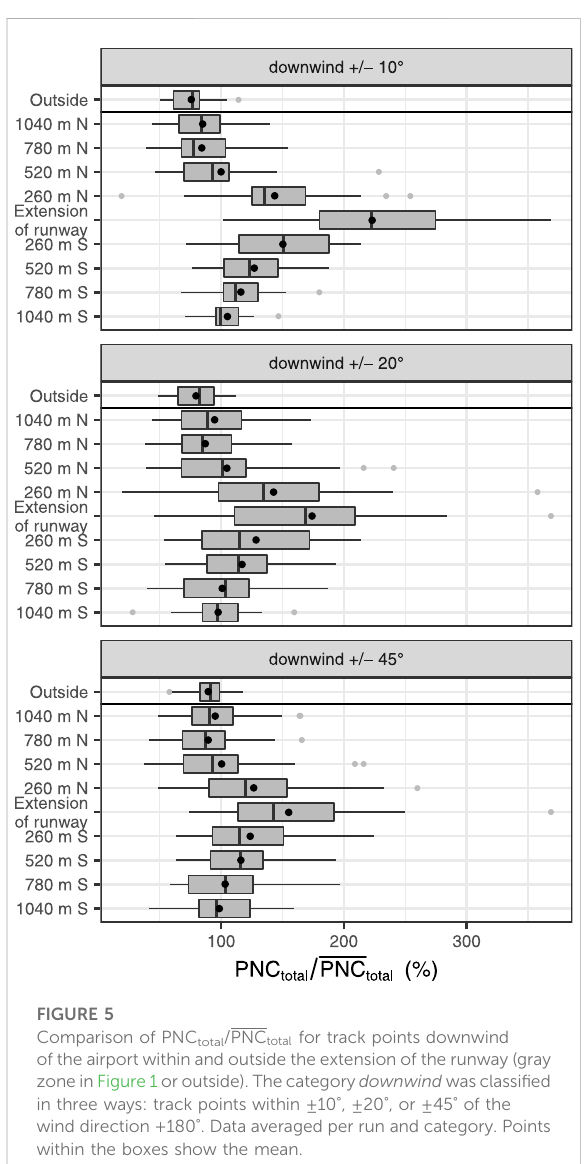
FIGURE 5 Comparison of PNC total /PNC total for track points downwind of the airport within and outside the extension of the runway (gray zoneinFigure1oroutside).Thecategory downwind wasclassi fi ed in three ways: track points within ±10 ° , ±20 ° , or ±45 ° of the wind direction +180 ° . Data averaged per run and category. Points within the boxes show the mean.